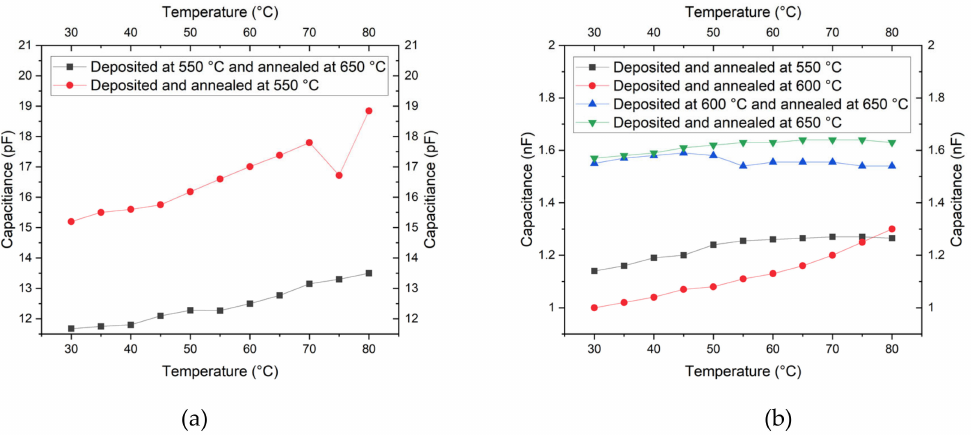
Figure 8. Variation of Capacitance for the PCT films deposited on ( a ) Si / SiN / Ti / Au and ( b ) Si substrates,